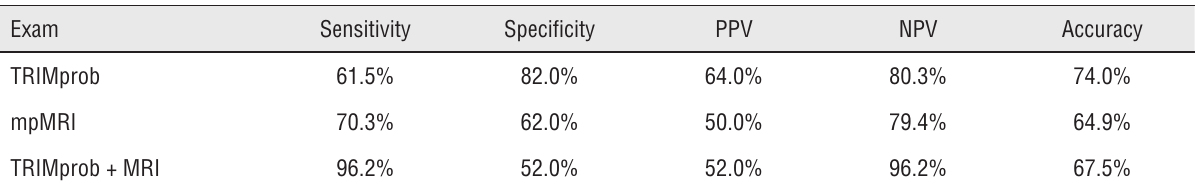
Table 3 - Sensitivity, specificity, PPV, NPV and accuracy of TRIMprob and mpMRI and the combination of both in 77 patients submitted to prostate biopsy.